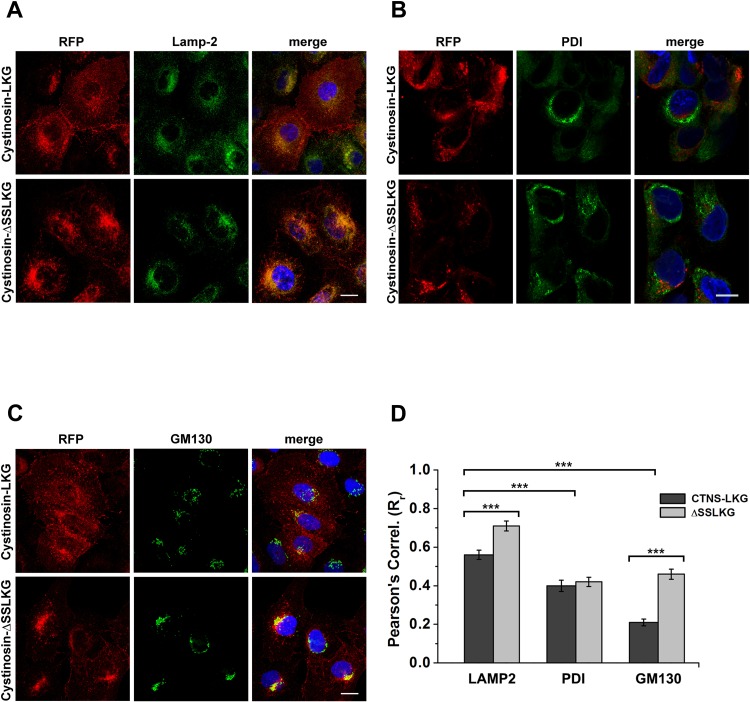
Subcellular distribution of the cystinosin-LKG and ΔSSLKG mutant.HK-2 cells were stably transfected with RFP-tagged cystinosin-LKG or with its mutated form, deleted in C-terminal tail for the last five amino acids (ΔSSLKG). Cells were immunolabeled with LAMP-2 for lysosomes (A), PDI for endoplasmic reticulum (B), GM130 for Golgi (C). Scale bar = 10 μm. Analysis of ROIs (Regions of Interest) shows a Pearson’s Correlation (Rr) for RFP with LAMP-2 greater than with other organelle markers (p < 0.0005). In particular, the mutant ΔSSLKG shows an Rr for LAMP-2 significantly increased (p < 0.0005) compared to the wild type cystinosin-LKG. The presence of cystinosin-LKG and ΔSSLKG mutant on ER is low, moreover the analysis shows very low expression of cystinosin-LKG in the Golgi apparatus, whereas high Rr for GM130 in ΔSSLKG mutant suggests that it is accumulated significantly (p < 0.00001) on the Golgi apparatus (D). Means ± SEM of three experiments are shown.